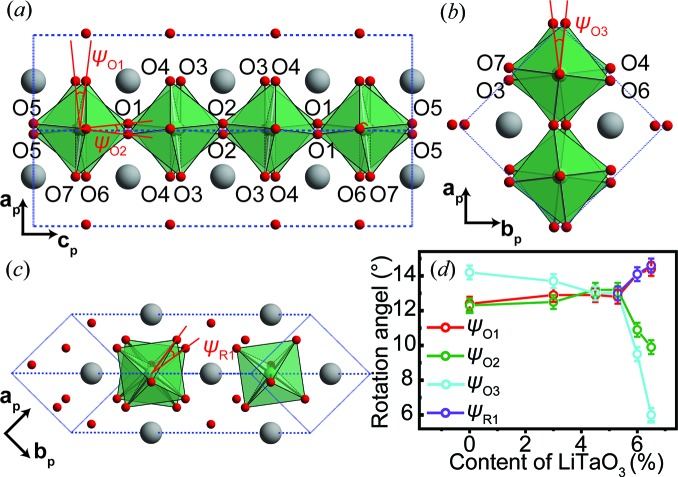
The distorted structure induced by (a) the T4+ mode for the Pmc21 phase viewed along the b
p axis, (b) the H2 mode for the Pmc21 phase viewed along the c
p axis and (c) the R4+ mode for the R3c phase viewed along the c
p axis. (d) The LiTaO3 content-dependent rotation angles.